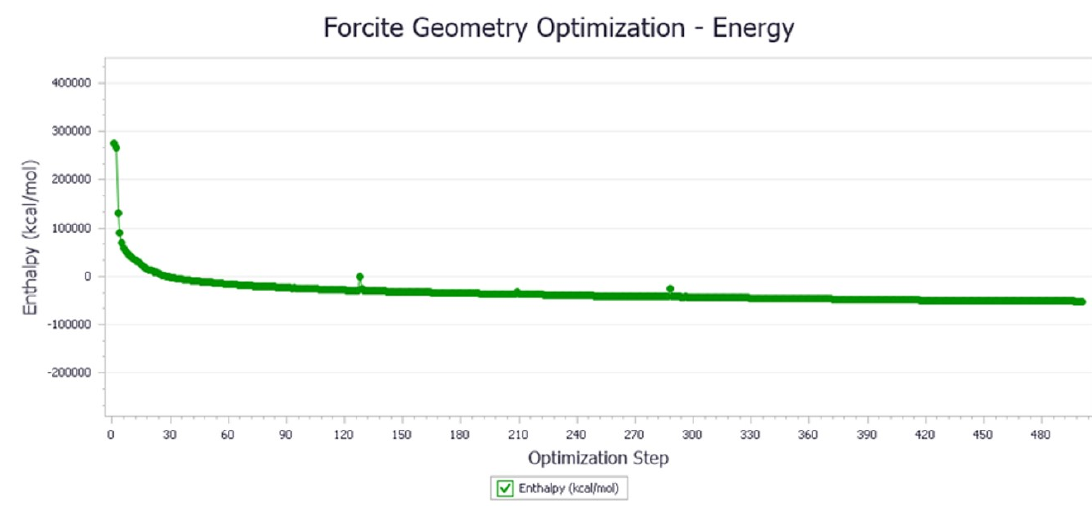
Figure 12. Demulsifier8 # oil–water interface geometry optimization energy